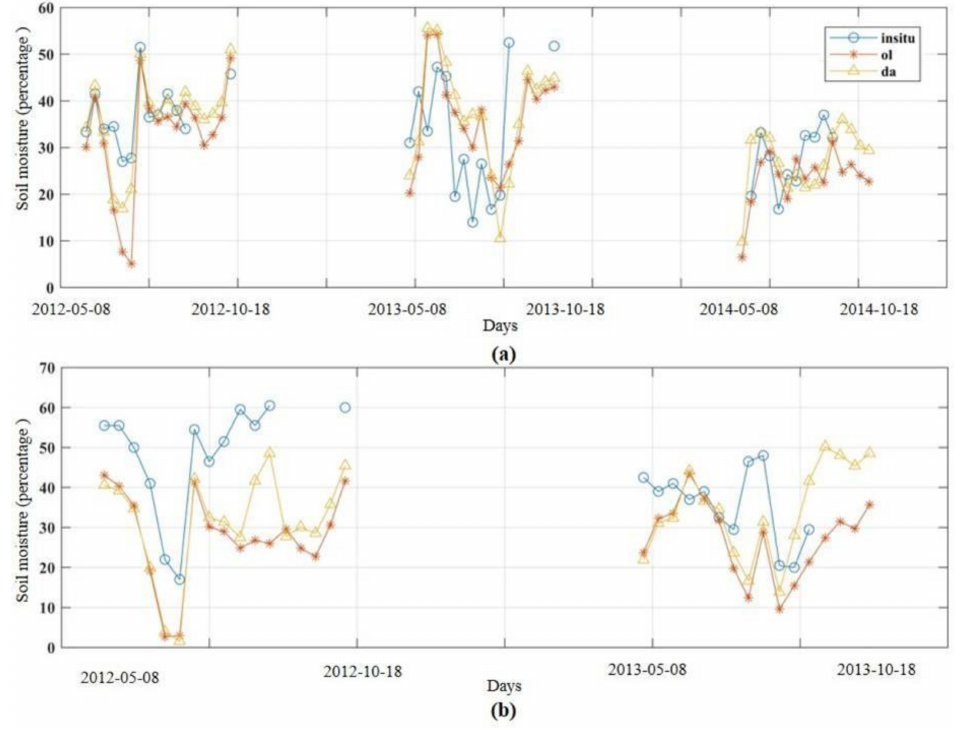
Figure 8. Surface soil moisture validation of open loop and after data assimilation with respect to in situ measurement over ( a ) Tulun station, ( b ) Ikey